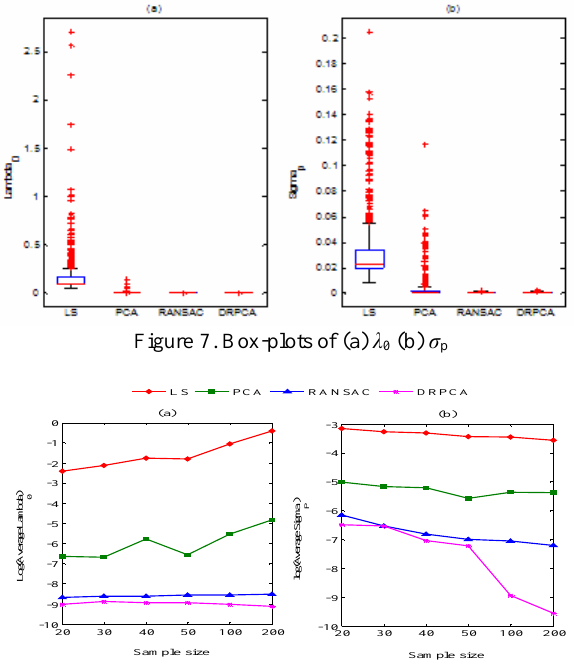
Figure 8. Log average (a) λ 0 , and (b) σ p ; w.r.t. sample